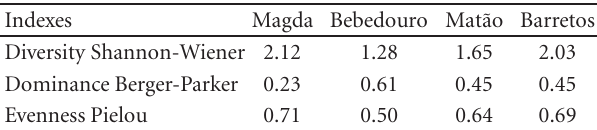
Table 2: Diversity, dominance and evenness indexes of the four areas